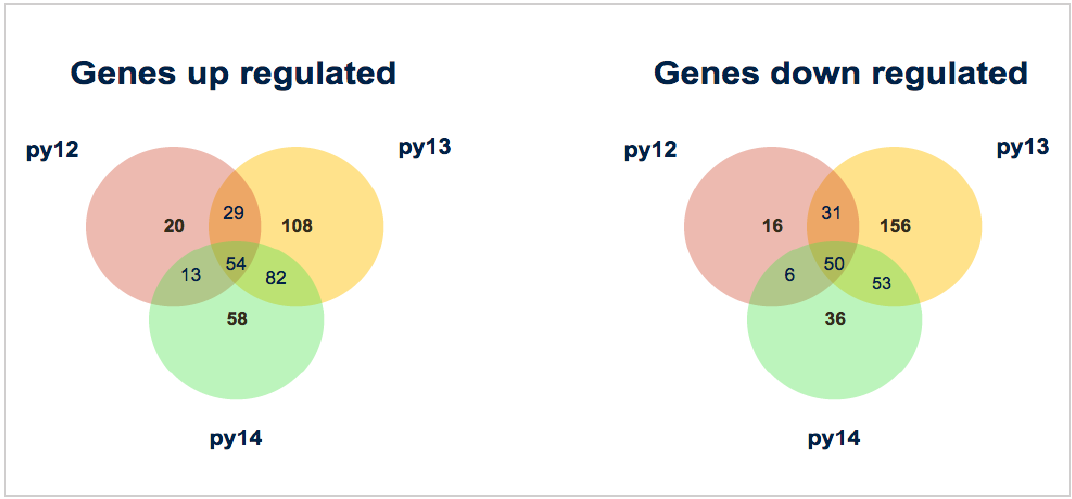
Figure 6. Representation of differential expressed genes (DEG) interactions over KEGG pathways between neighboring data sets. The number of DEG interactions shared by neighbor data sets were shown in the overlapping regions.